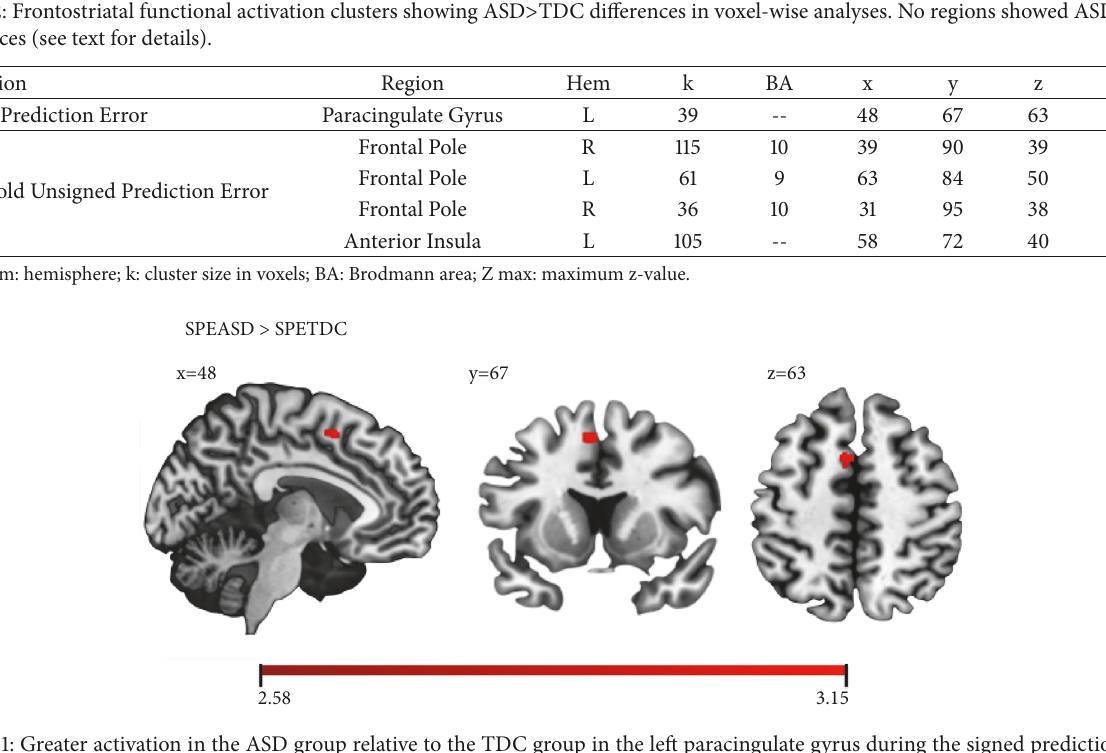
Figure 1: Greater activation in the ASD group relative to the TDC group in the left paracingulate gyrus during the signed prediction error (SPE) contrast. Color bar represents the range of